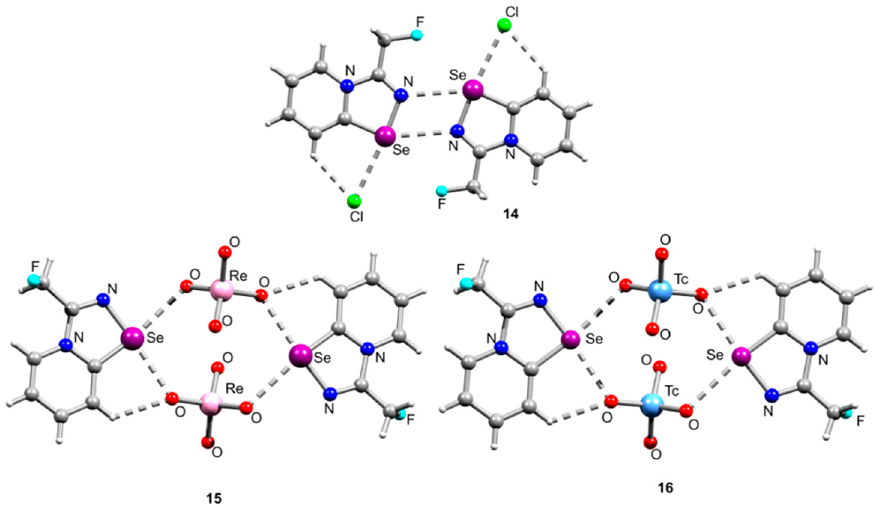
Figure 11. Ball-and-stick representation of crystal structures 14 – 16 demonstrating supramolecular dimerization via various ChB interactions.